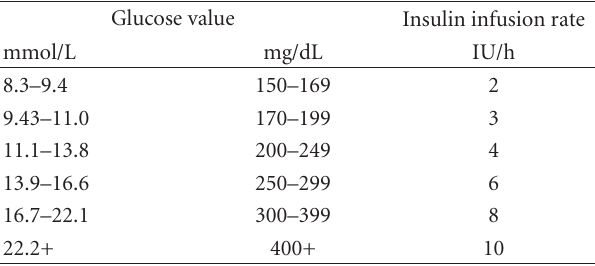
Table 4: Proactive regimen: dilute 100 U of insulin in 100 mL of isotonic saline solution 0.9% (1U = 1mL). Administer via infusion pump according to the following scheme. The measurement unit used for indicating the concentration of blood or plasma glucose can either have a weight dimension (mg/dL) or a molarity (mmol/L).